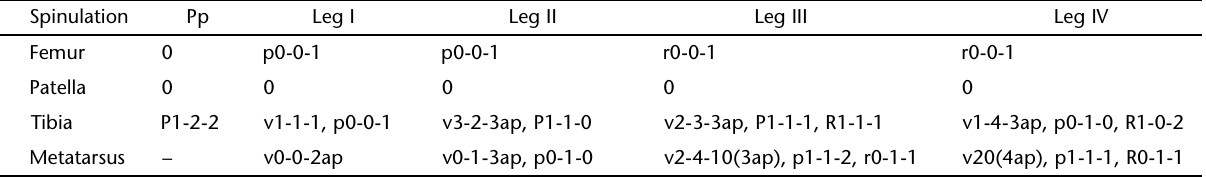
Table II. Vitalius nondescriptus comb. nov. Holotype male MNRJ 43 from Ouro Preto, state of Minas Gerais, Brazil. Spinulation of right legs and palpal segments. Spinulation